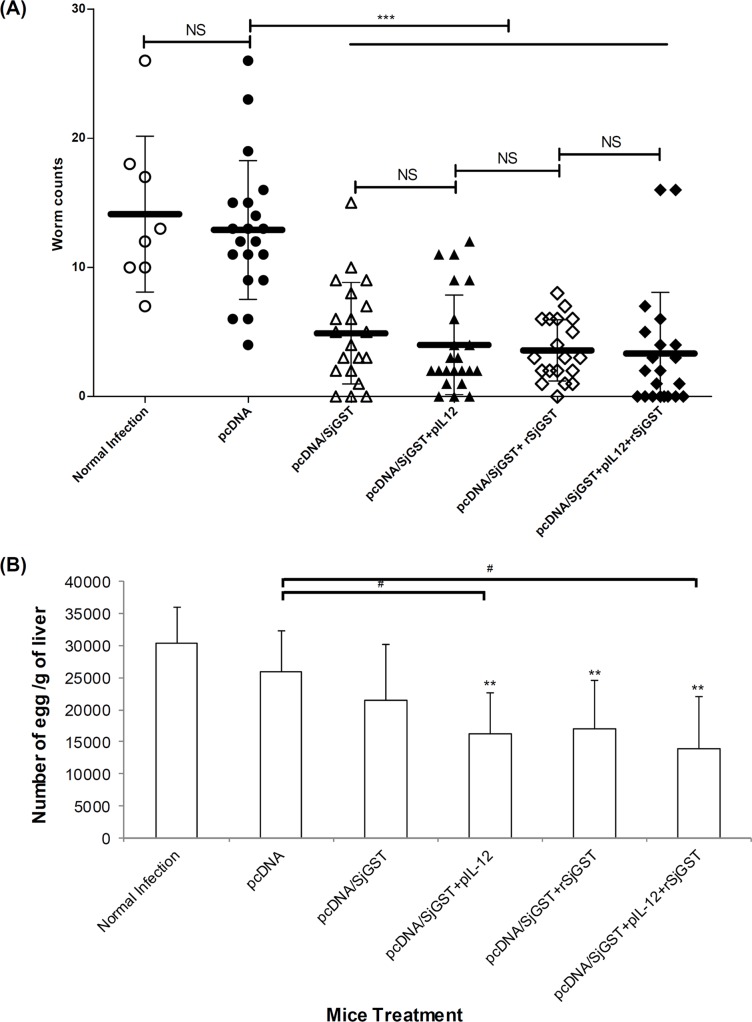
The worm and hepatic egg burdens of vaccinated animals challenged with Schistosoma japonicum.Six groups of mice were immunized with pcDNA4 vehicle, pcDNA/SjGST vaccine, pIL-12 and rSjGST. The vaccinated mice were infected with 30 cercaria/ mouse. Each group included 19–21 animals (with the exception of Group I, n = 8) from three independent experiments. Eight weeks after schistosome infection, (A) adult worms were collected from infected mice and counted under an anatomy microscope. Each point represents the number of worms in a single mouse. The horizontal black lane represents the mean ± SD of that group. NS: not significant; ***: p < 0.001 between different groups. (B) In addition, parts of the mice livers were collected, weighed, and digested for egg counting. Mean ± SD are shown. *: p < 0.05, **: p < 0.01, compared with the untreated infection control. #: p < 0.05, compared between the two indicated groups.